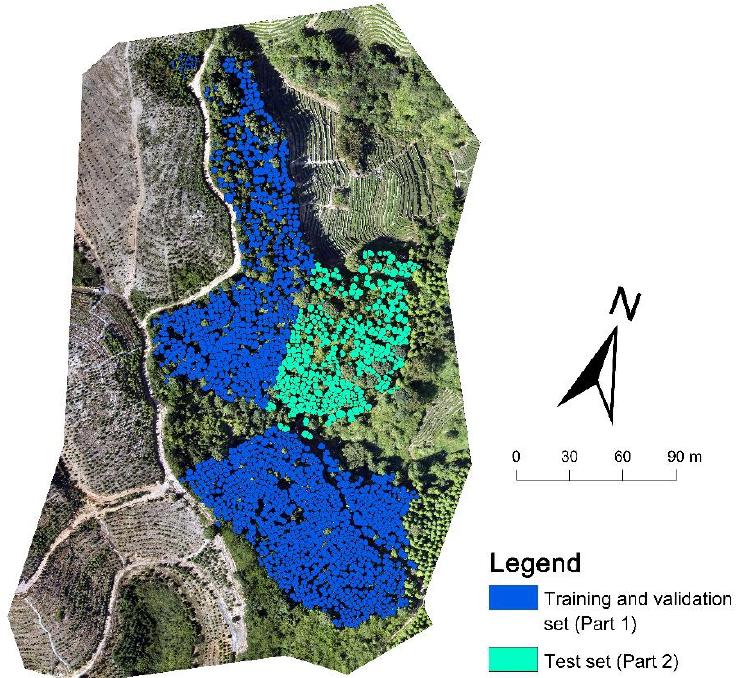
Figure 3. The distribution of the manually delineated trees. The manually delineated trees in part 1 are shown with blue boundaries, and the manually delineated trees in part 2 are shown with green boundaries.